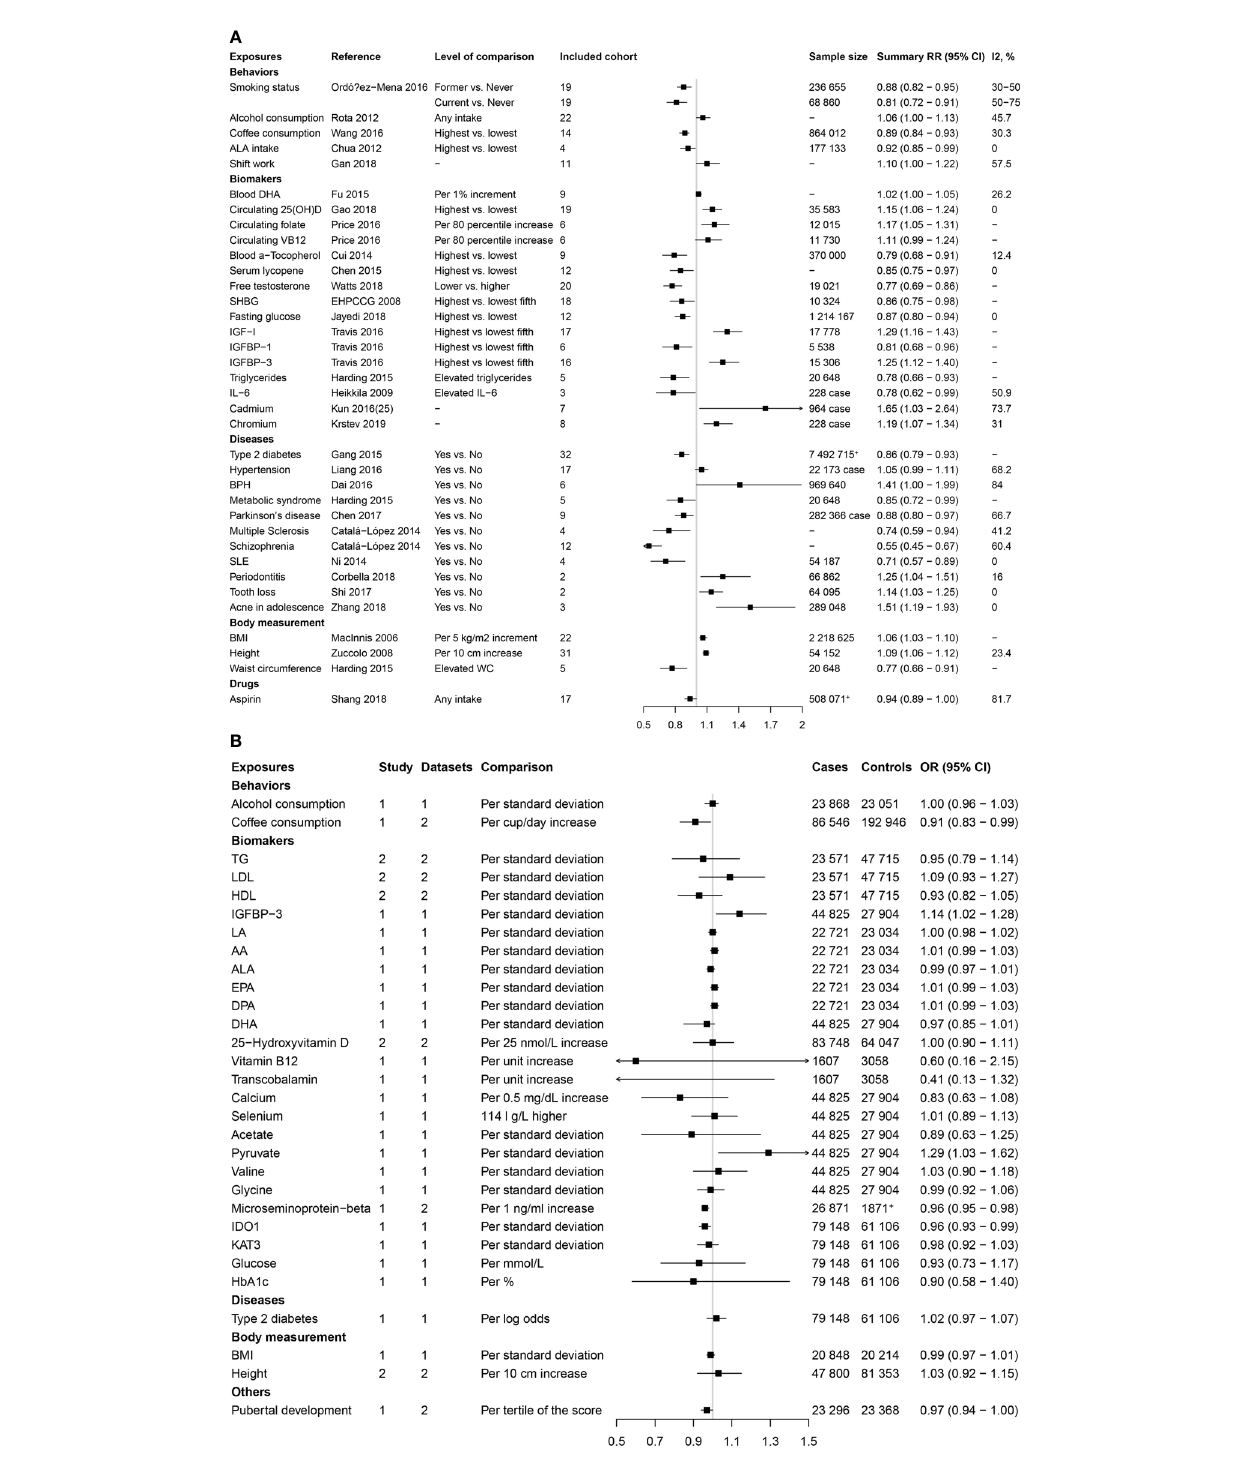
FIGURE 2 | Factors of prostate cancer that were identi fi ed by the published systematic reviews and meta-analyses of cohort studies and mendelian randomization studies. (A) Factors identi fi ed by the published systematic reviews and meta-analyses of cohort studies. (B) Factors identi fi ed by the published mendelian randomization